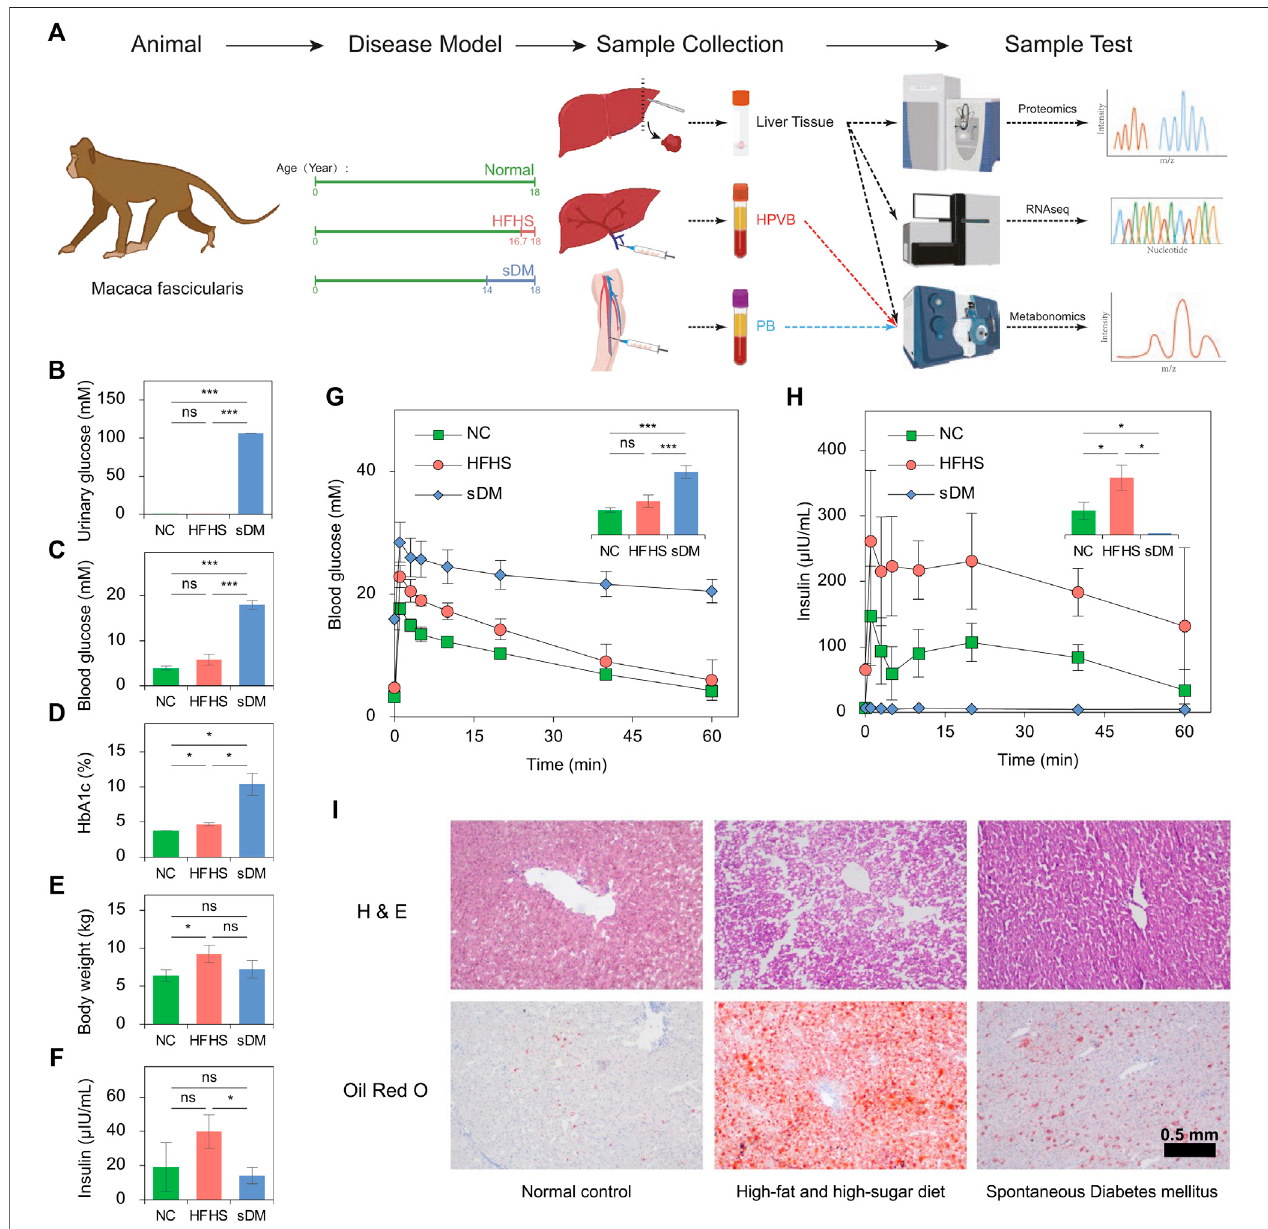
FIGURE 1 | The design of the experiments. (A) Experimental work fl ow. Three groups of Macaca fascicularis were sacri fi ced and their liver, PB, and HPVB were collected for metabolomic, transcriptomic, and proteomic pro fi ling. (B – F) The comparison of urinary glucose (B) , blood glucose (C) , HbA1c (D) , bodyweight (E) , and insulin (F) betweenthegroups. (G) and (H) Thechangesinbloodglucose (G) andinsulin (H) duringIVGTT. (I) Therepresentativesofthehistochemicalstainingresultsof the macaque livers from the three groups.